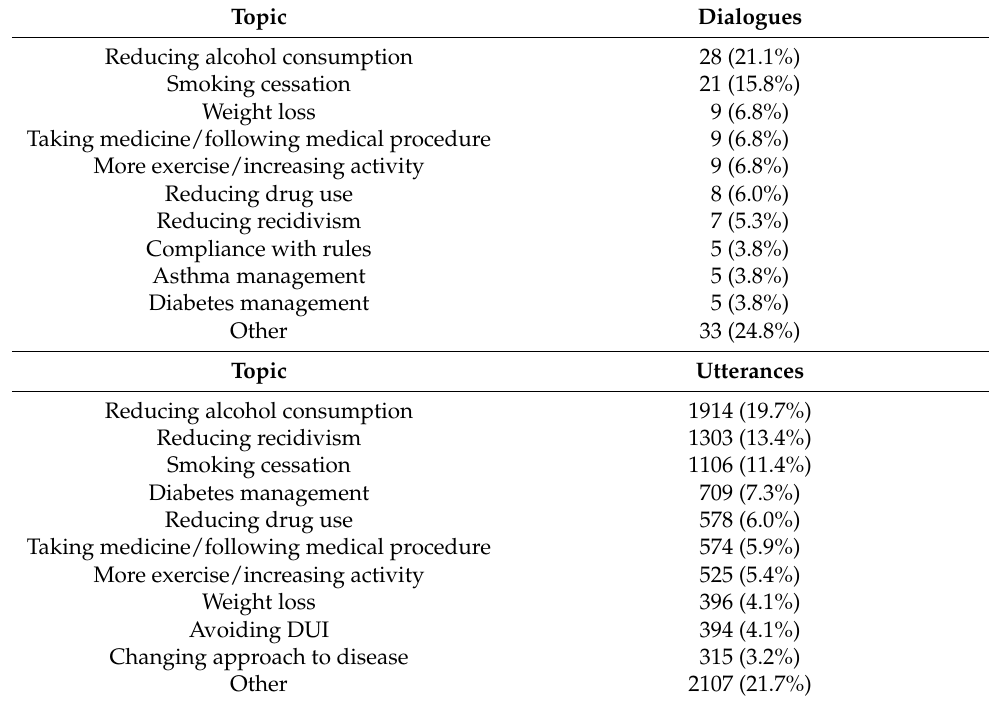
Table 3. Top 10 topics in AnnoMI in terms of (a) number and percentage of dialogues that have those topics, and (b) total number and percentage of utterances in those dialogues.